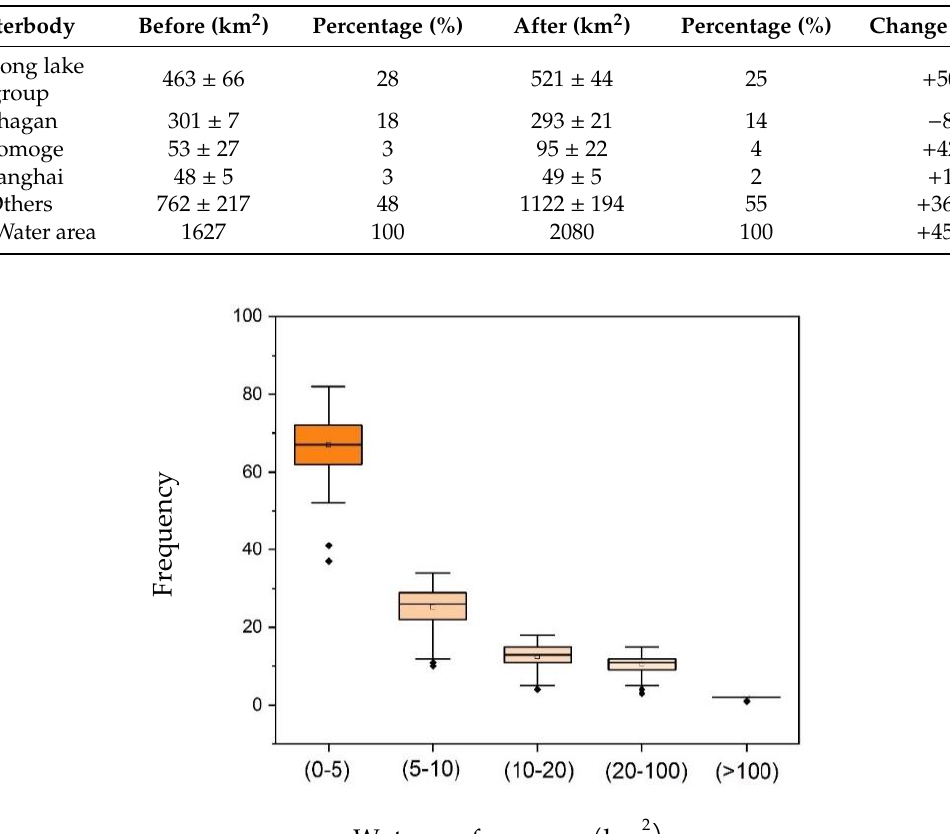
Table 1. Mean surface areas ( ± standard deviation) of open waterbodies in the Nenjiang River Basin (NRB), Northeast China, before and after the construction of the Nierji Dam in 2005.